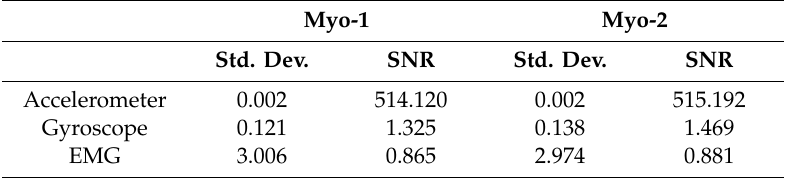
Table 3. Comparison of EMG and IMU data quality between two armband sensors for at-rest activity. Myo-1 Myo-2 Std. Dev. SNR Std. Dev.